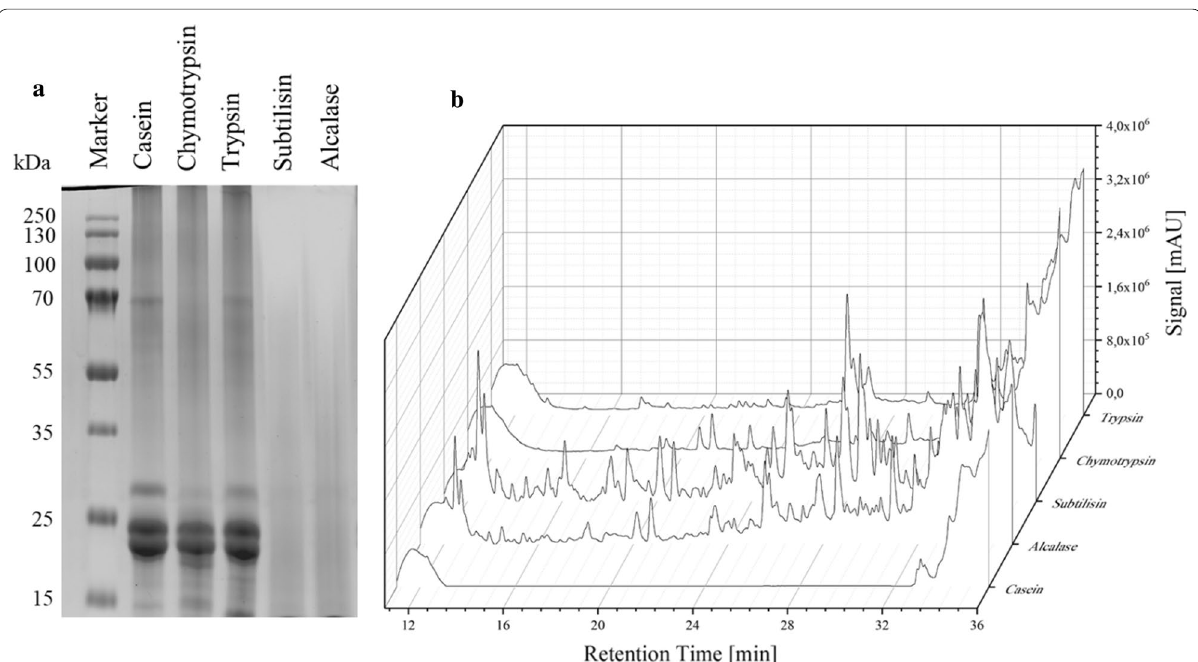
Fig. 2 Proteolytic batch digestion of casein by different proteases. a Non-reduced SDS-PAGE 12% Tris gel stained with Coomassie Brilliant Blue